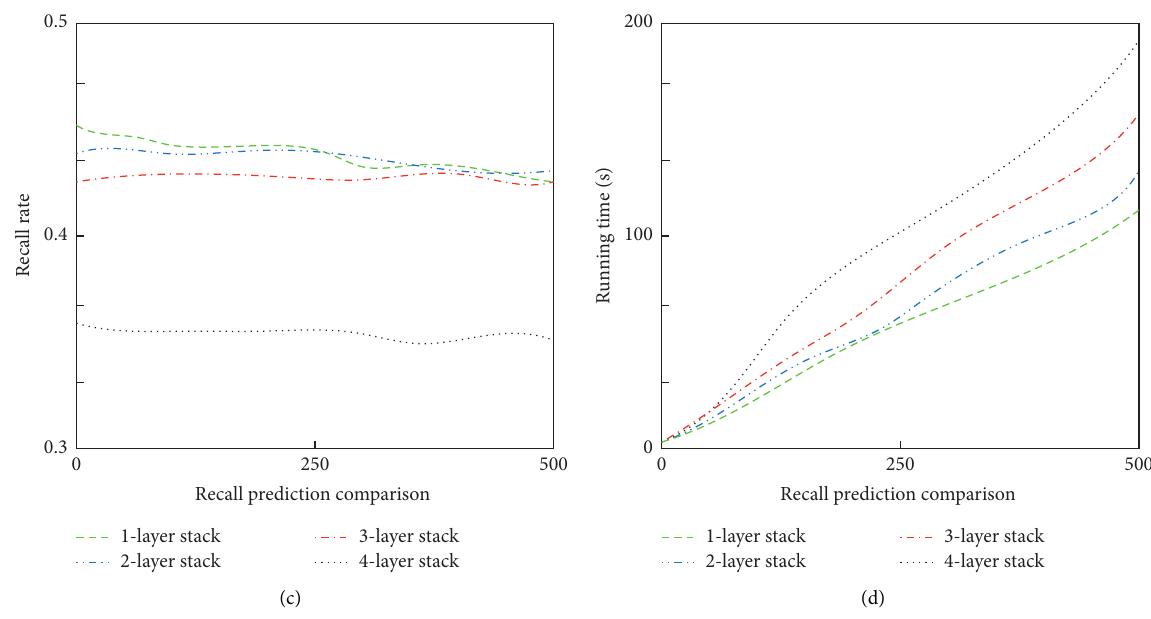
Figure 7: The effect of the depth of the stacked forest and the number of trees on the performance of the prediction model: (a) comparison of accuracy prediction; (b) accuracy prediction comparison; (c) horizontal convergence of mine crossing; (d) comparison of runtime